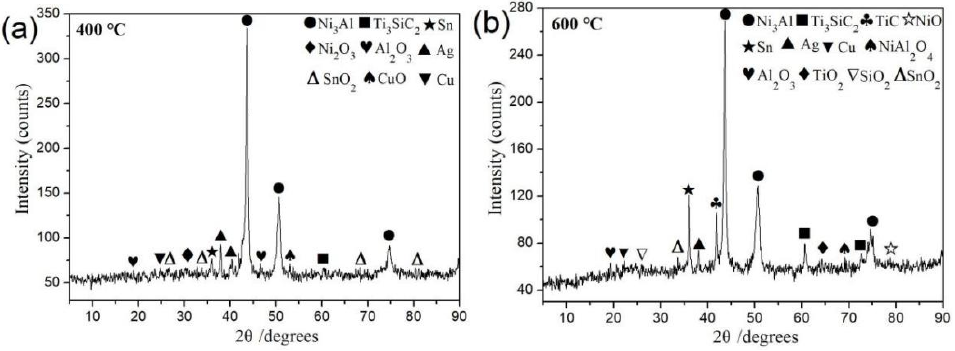
Figure 11. XRD results of worn surfaces of NST at 400 ( a ) and 600 °C ( b ).